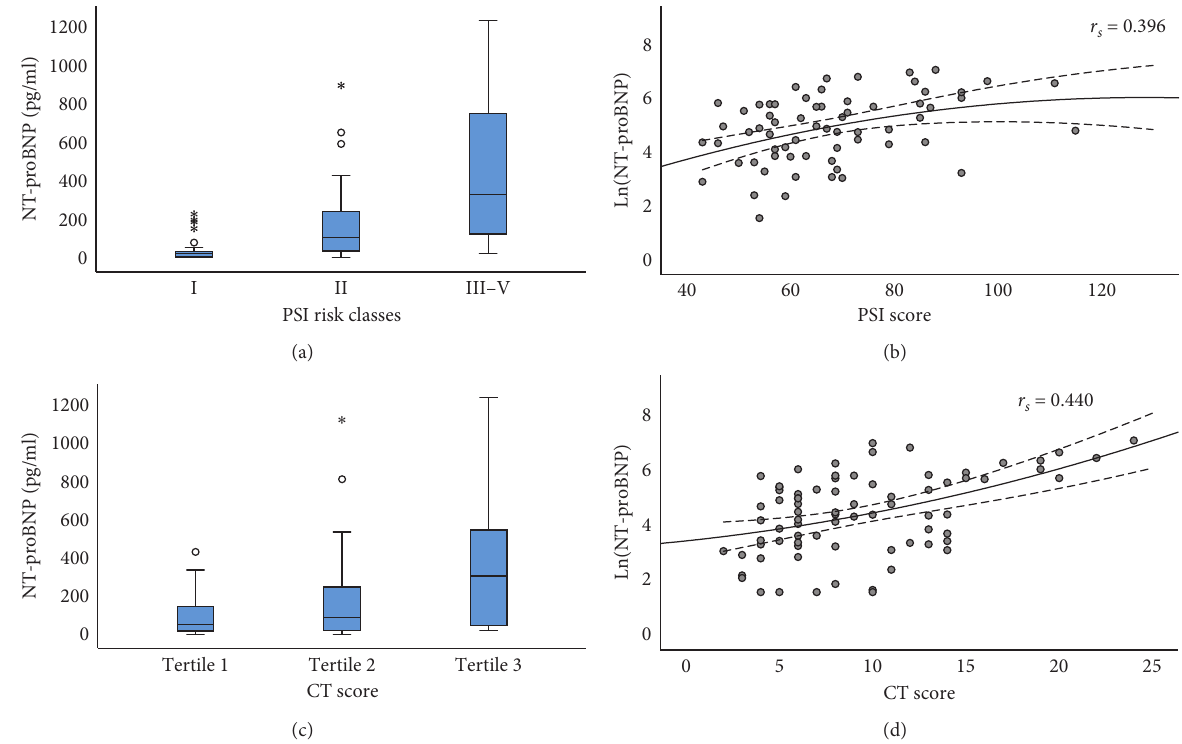
Figure 2: The box plots and the scatter plots of NT-proBNP levels with PSI classes or CT scores. (a) The box plot showing significant difference in NT-proBNP levels across PSI classes ( P < 0 . 001). (b) The scatter plot showing the positive correlation between the natural logarithm of NT-proBNP level and PSI score ( r S � 0.396, P � 0 . 001). (c) The box plot showing a significant difference in NT-proBNP levels across CTscore tertiles ( P � 0 . 005). (d) The scatter plot showing that the natural logarithm of NT-proBNP level was significantly associated with CTscore ( r S � 0.471, P < 0 . 001). NT-proBNP: N-terminal pro-B-type natriuretic peptide; PSI: pneumonia severity index; CT: computed